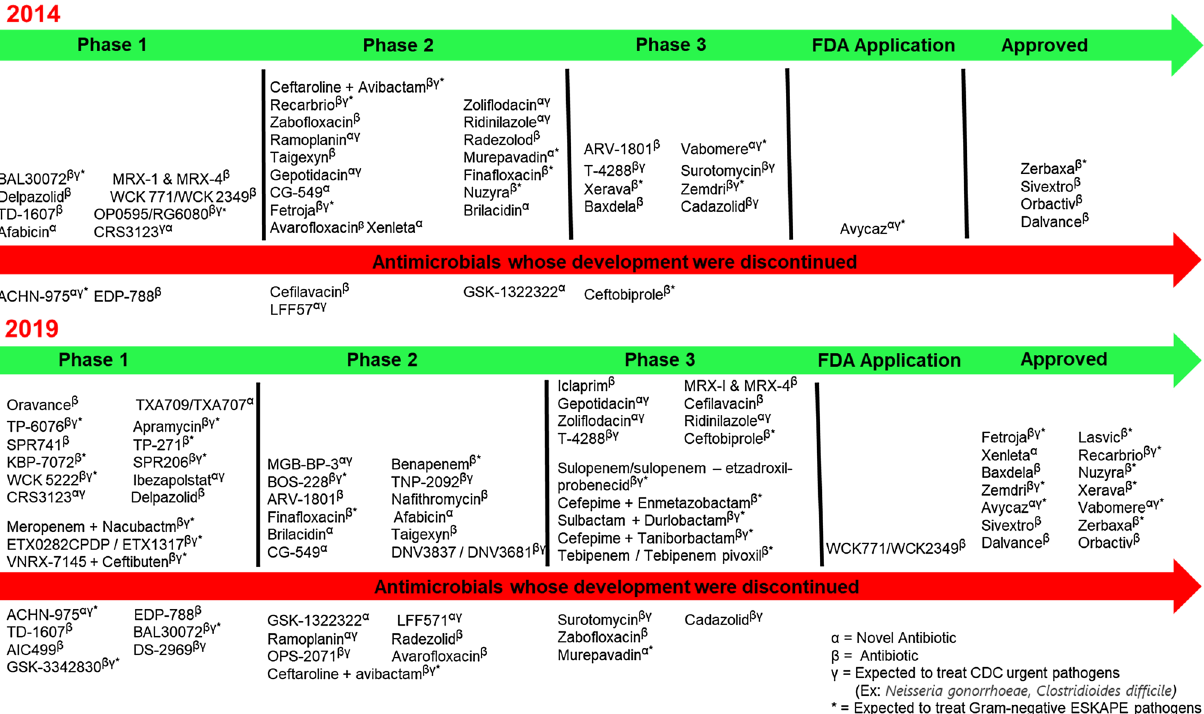
resources and there are very few novel antibiotics under develop- ment. The declining number of antibiotics in the development pipeline, in part, reflects the challenges associated with its develop- ment. At the same time, bacteria that survives antibiotic treatment are